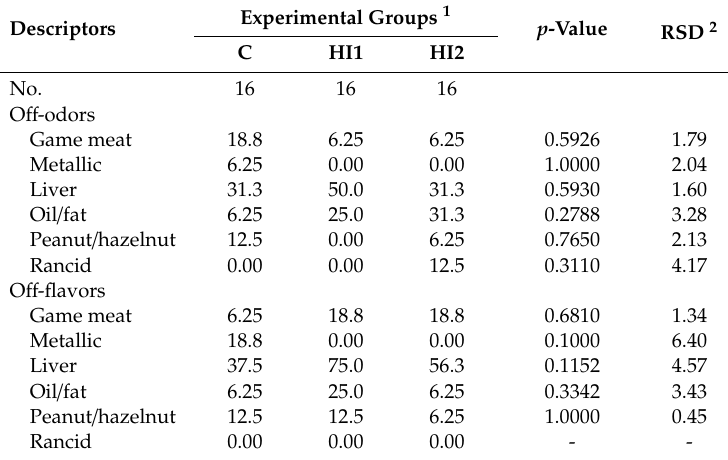
Table 7. Effect of the dietary inclusion of Hermetia illucens dried larvae farmed on different growth substrates (HI1, HI2) on the off-odors and off-flavors (% of total tested samples) of broiler quails’ breast